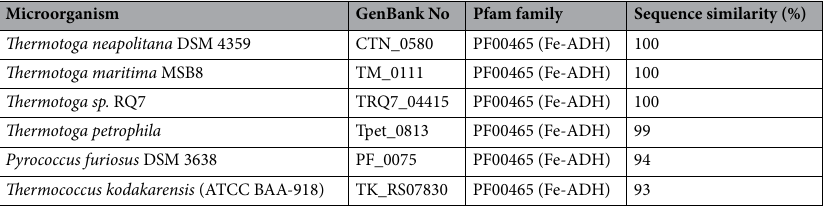
Table 3. Distribution of Fe-AAdh in some